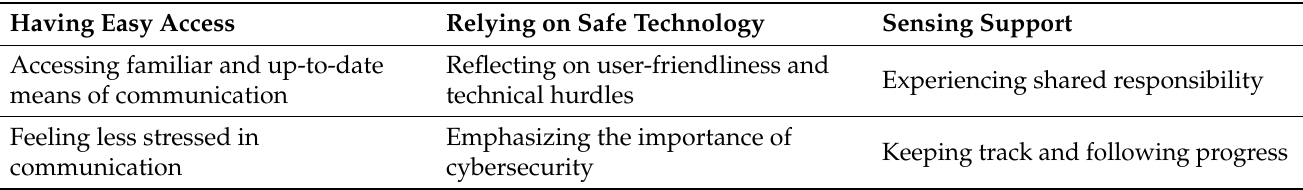
Table 4. Themes and sub-themes of parents’ experiences of communicating with healthcare professionals through an eHealth device after hospital